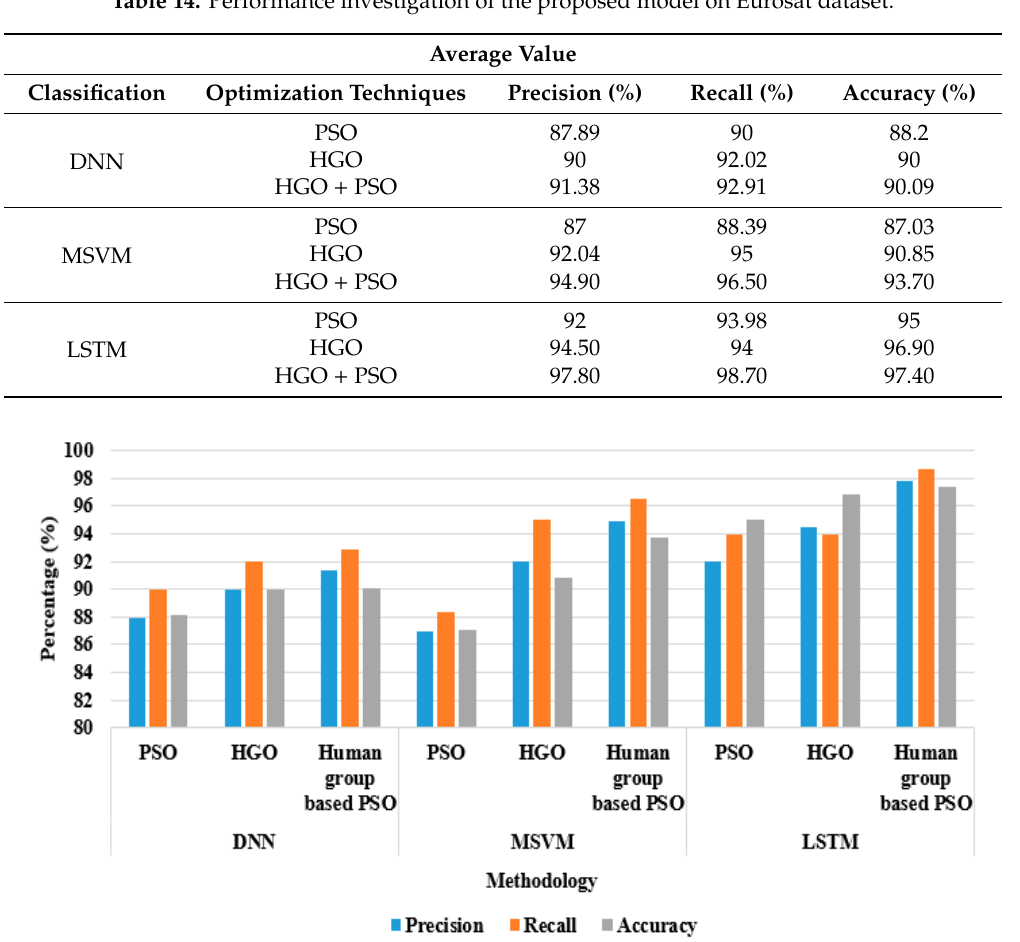
Figure 14. Graphical investigation of the proposed model on Eurosat dataset. Table 14. Performance investigation of the proposed model on Eurosat dataset.